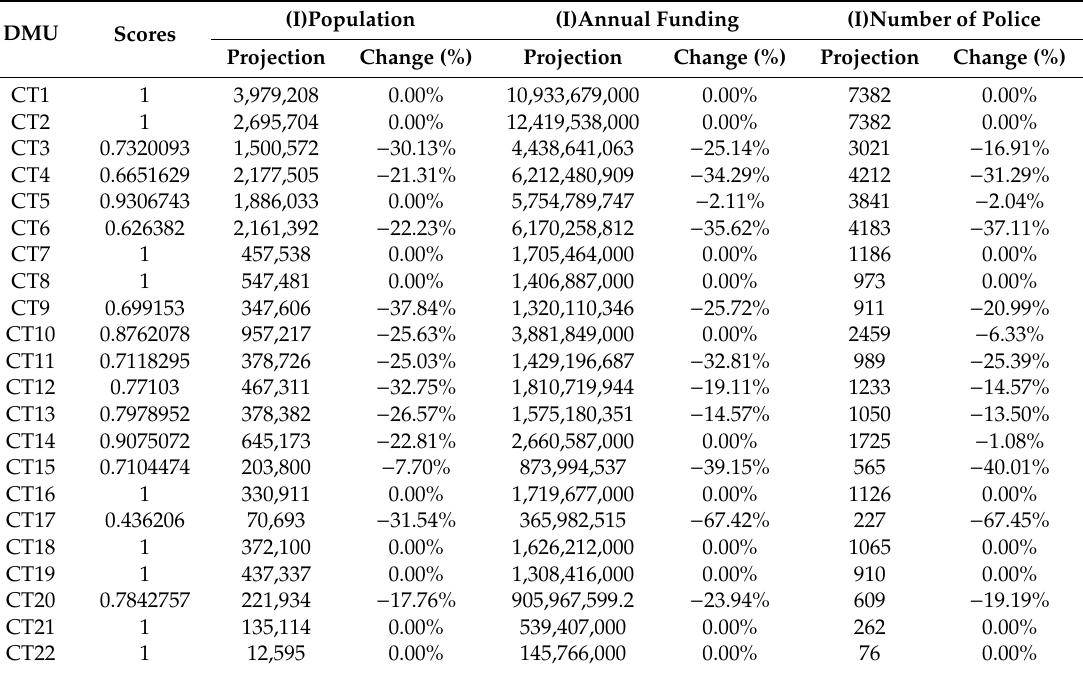
Table 7. Input factor projections.